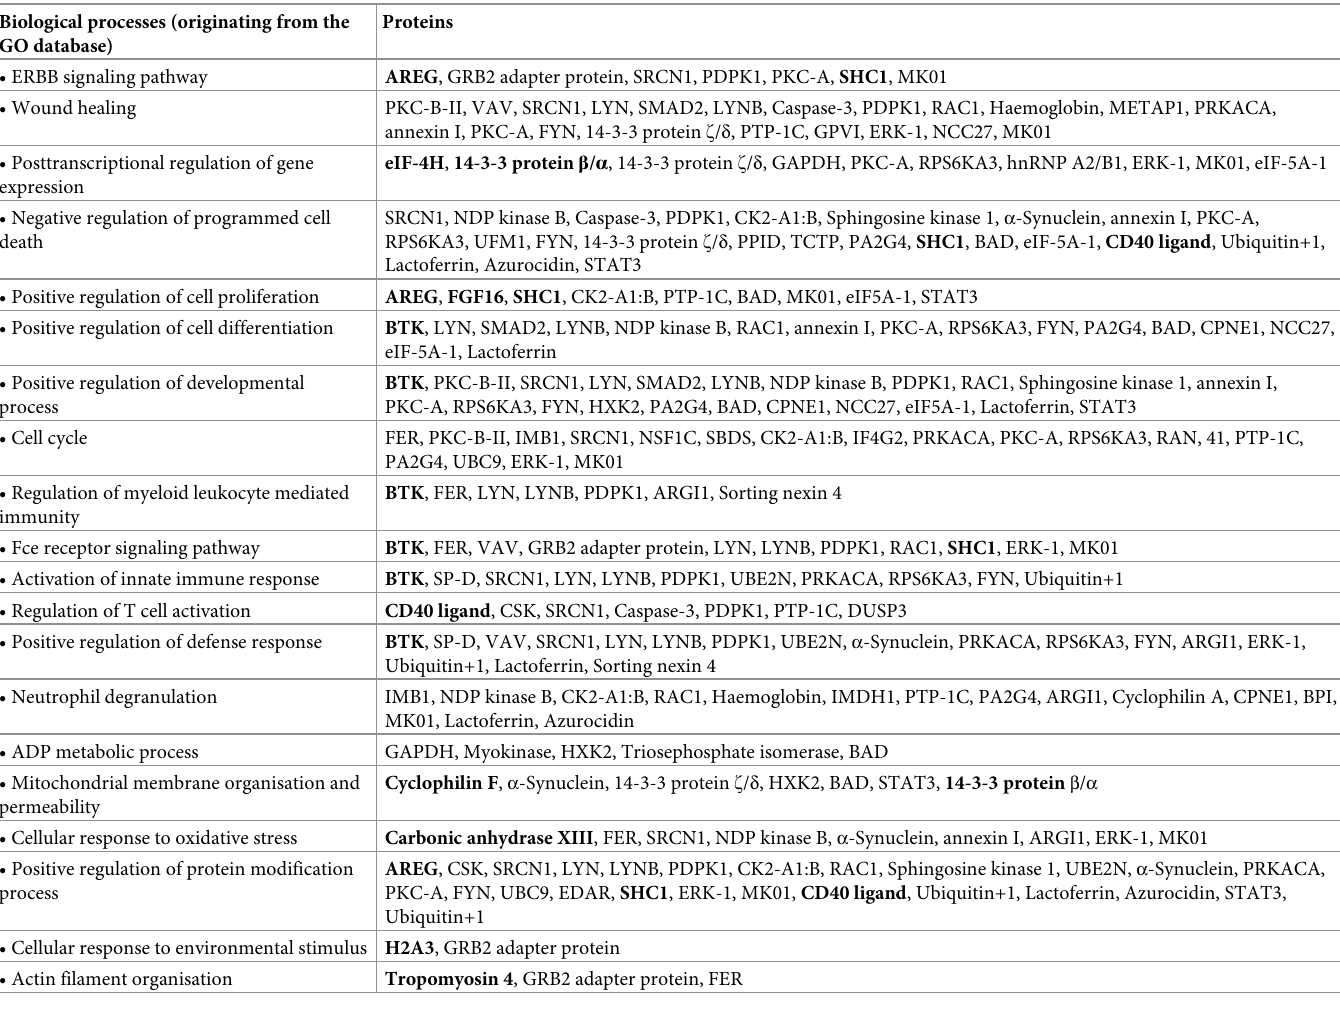
Table 1. Biological classification of the top 90 proteins enriched in Cluster 2 COPD patients. Biological processes (originating from the GO